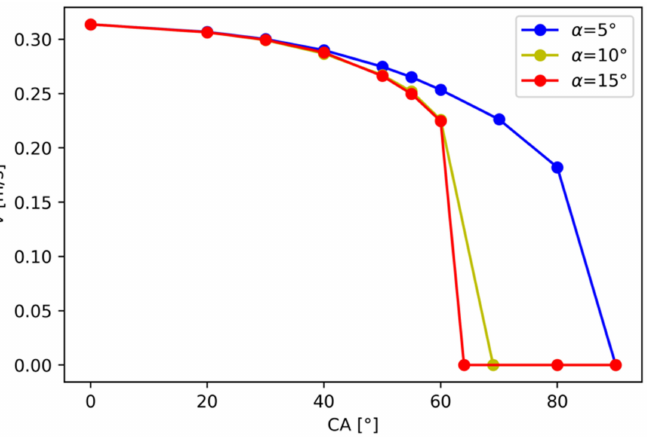
Figure 15. v as a function of CA for stripes coating. The CA is related to the compartments of the particle surface whose wettability is reduced.